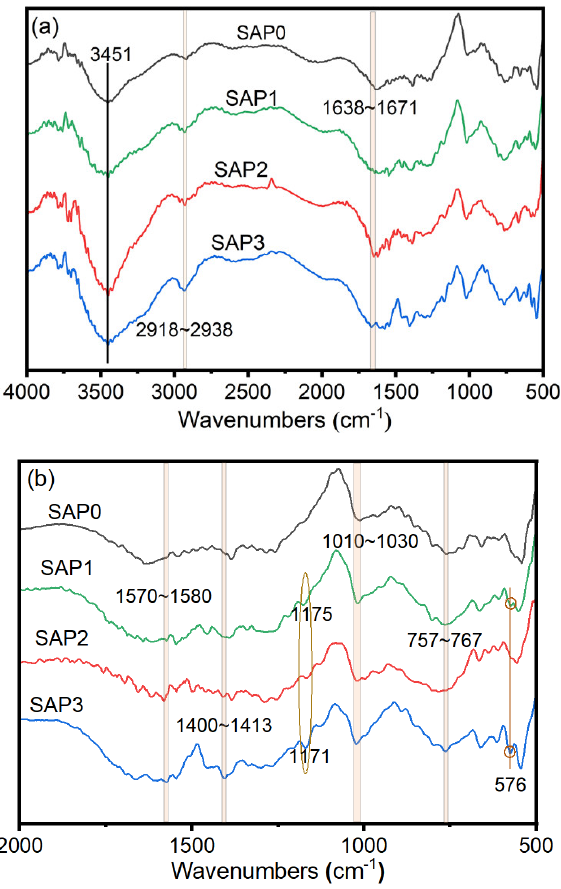
Figure 2. ( a ) Infrared spectra from 4000 to 500 cm − 1 and ( b ) enlarged infrared spectra from 2000 to 500 cm − 1 of SAP0, SAP1, SAP2, and SAP3.